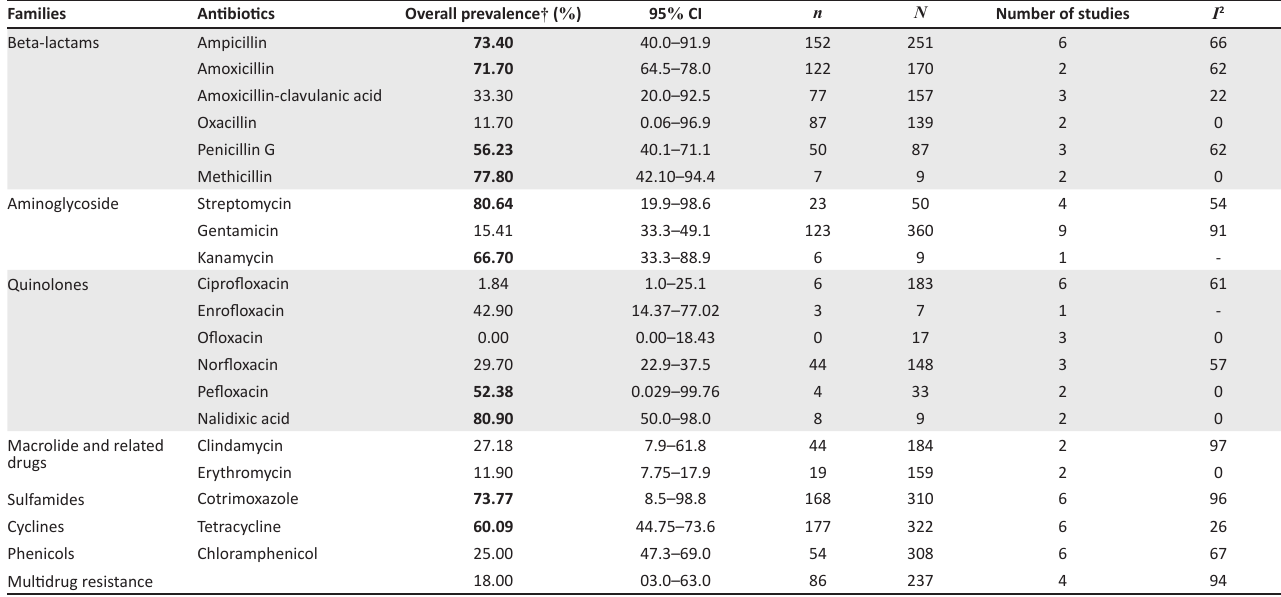
TABLE 2: The overall prevalence of antibiotic resistant Staphylococcus aureus strains isolated from dogs in Africa.